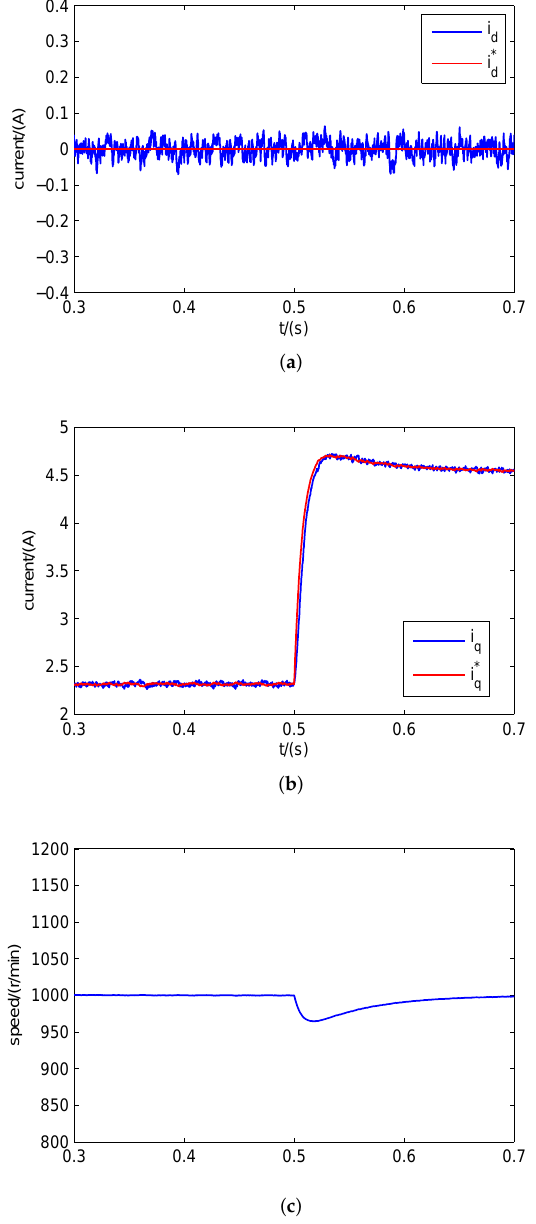
Figure 6. Simulation results with the proposed method when the load torque changed: ( a ) d-axes current, ( b ) q-axes current, and ( c ) speed